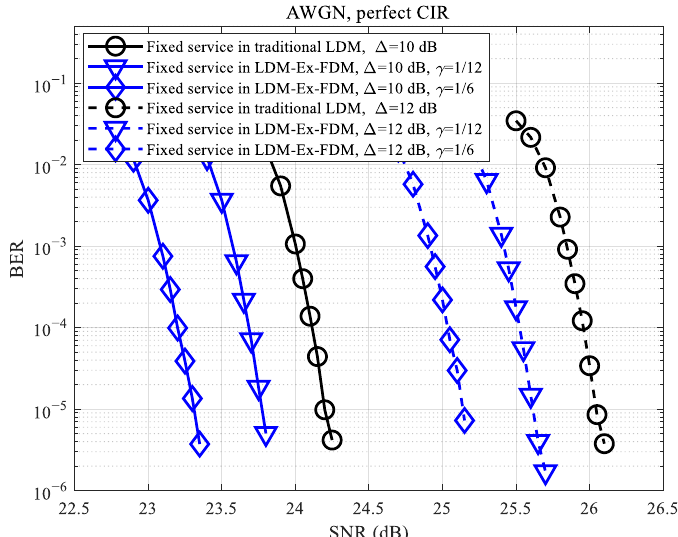
Figure 13. BER performance of fixed service in ATSC 3.0 system with and without LDM-Ex-FDM scheme with perfect channel impulse response (CIR) over the AWGN channel, where the parameters of the ATSC 3.0 system were set to ∆ = 10 and 12 dB, the CL constellation was set to QPSK, the EL constellation was set to NU − 64QAM, and the puncturing rate of the LDM-Ex-FDM scheme were set to 1/6 and 1/12.